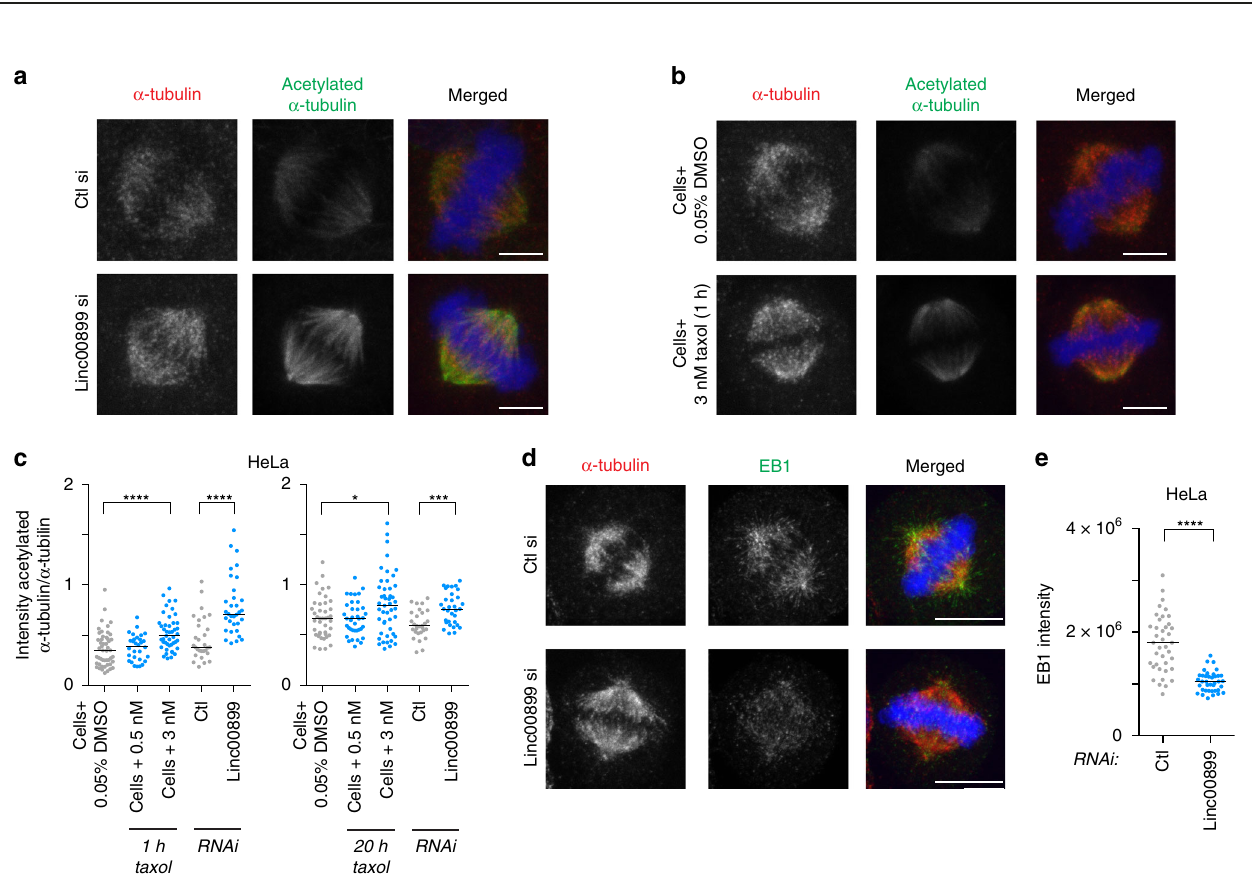
Fig. 4 TPPP , a microtubule-stabilising protein, is a target of linc00899 in regulation of mitosis. a Venn diagram of DEGs detected by RNA-seq after depletion of linc00899 and C1QTNF1-AS1 using RNAi and LNA1 gapmers. The total number of genes was 17022. b Heat map of DEGs detected with RNA- seq after depletion of linc00899 using RNAi and LNA gapmers. Three to four biological replicates were generated for each condition and compared to appropriate negative controls (Ctl) — A and B for LNA gapmers, Ambion (Amb) and Dharmacon (Dh) for RNAi. Only DEGs changing in the same direction with both LOF methods are shown. Linc00899 itself is shown as a reference. c Genome tracks of RNA-seq coverage for linc00899 before and after depletion of linc00899 using RNAi or LNA1 gapmers. The tracks were constructed from averages of 3 – 4 biological replicates for each condition. d Genome tracks of RNA-seq coverage for TPPP , as in c . e Representative western blot of TPPP levels after depletion of linc00899 . β -Tubulin and p150 were used as two loading controls. f Densitometric analysis of TPPP levels in e . n = 6 biological replicates. ** P < 0.01 and *** P < 0.001 by two-tailed Student ’ s t test. g Quanti fi cation of mitotic duration of HeLa cells after single and double knockdown of linc00899 and TPPP using RNAi or LNAs. We analysed n = 153 for cells treated with transfection reagent alone (Cells), n = 187 for negative control siRNA (Ctl, from Ambion), n = 207 for TPPP siRNAs, n = 97 for linc00899 siRNAs, n = 204 for linc00899 and TPPP siRNAs, n = 182 for Ctl LNA A, n = 115 for linc00899 LNA1 and n = 246 for linc00899 LNA1 and TPPP siRNA. For each condition, we show the median with interquartile range from two biological replicates. **** P < 0.0001 by Mann – Whitney test. Mitotic duration was de fi ned from NEBD ( t = 0 min) to anaphase onset. h – i Expression of linc00899 and TPPP after single or double knockdown with RNAi ( h ) or LNA1 gapmers ( i ) to deplete linc000899 . n = 4 biological replicates, * P < 0.05, ** P < 0.01, *** P < 0.001 and **** P < 0.0001 by two-tailed Student ’ s t test. Data are shown as mean ± S.E.M. for f , h , i . Source data are provided as a Source Data fi le.